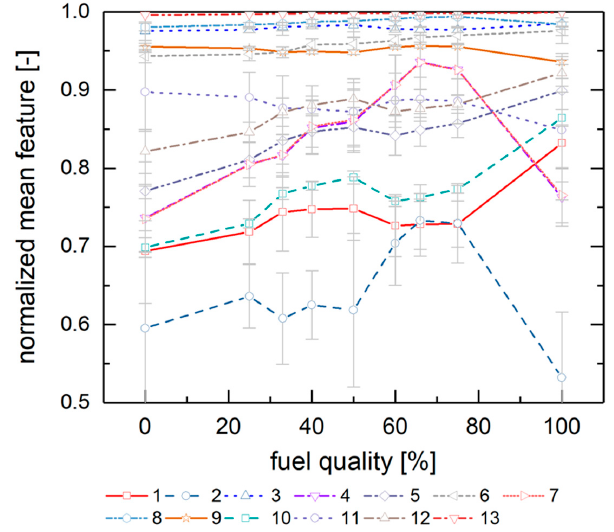
Figure 5. Extracted texture-based Haralick features as mean values with respect to the fuel quality class; error bars indicate the standard deviation.